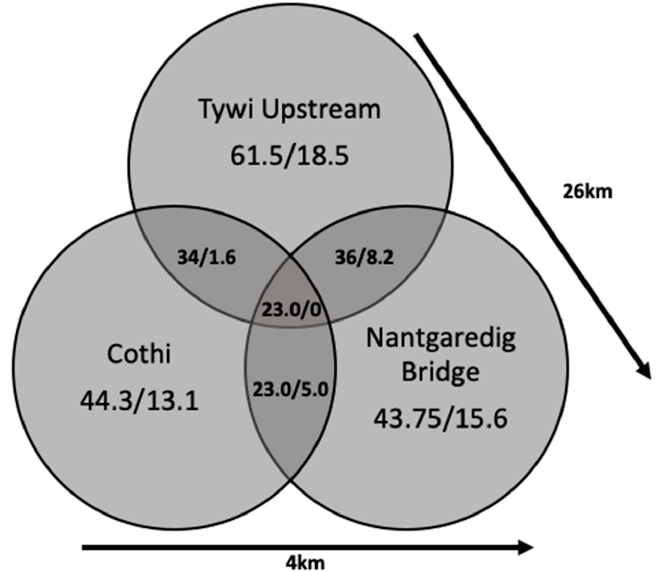
Figure 3. Detection of Map in the rivers Tywi and Cothi and at the confluence. (Arrow denotes distance from furthest sampling site (see Figure 1.) Data show detection of Map in individual rivers and when detected in others on the same sampling date.)